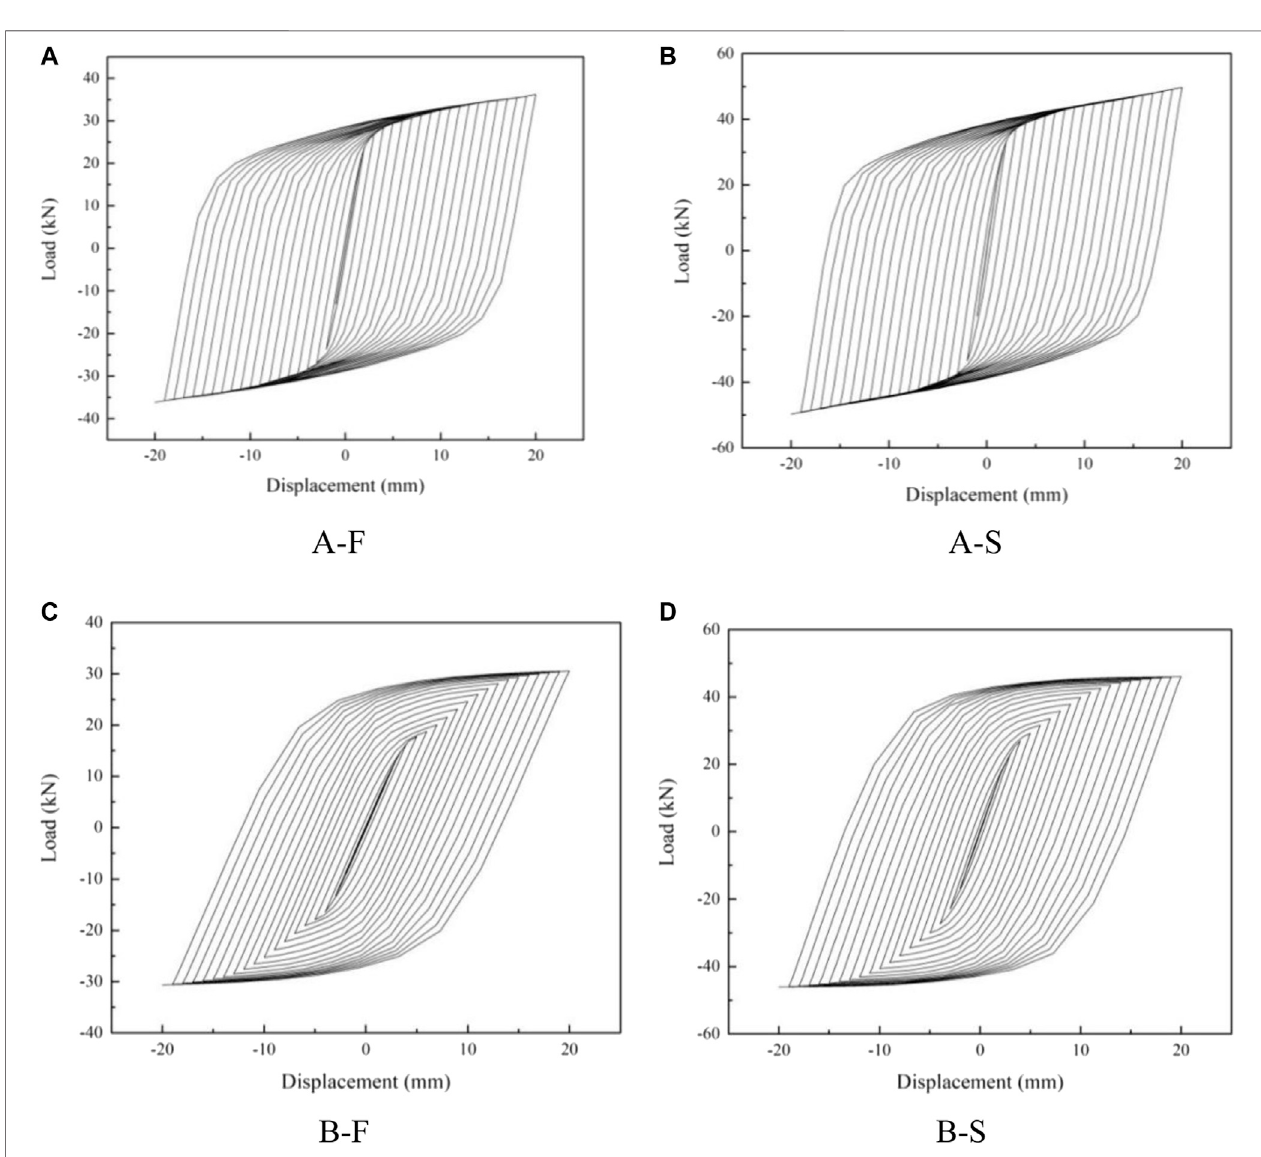
FIGURE 12 | Force-displacement hysteretic curve of the damper. (A) A – F, (B) A – S, (C) B – F, (D) B – S.